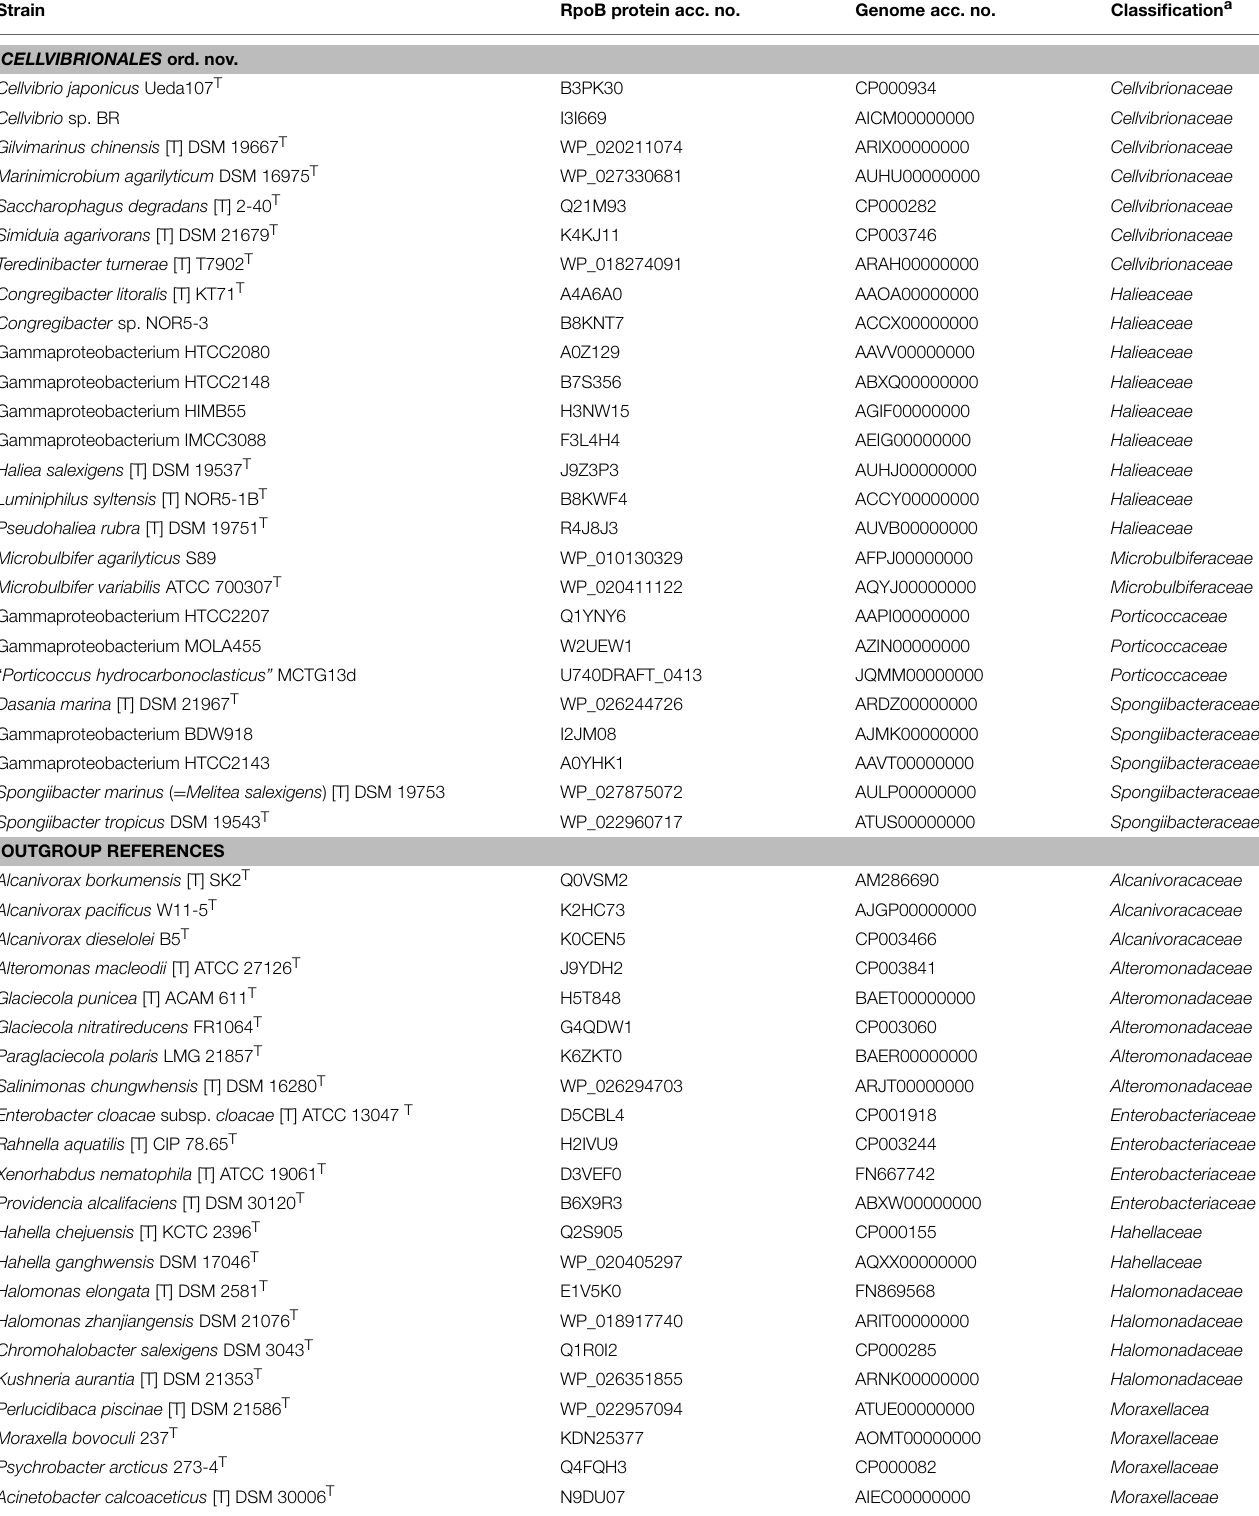
TABLE 1 | Dataset of RpoB protein sequences and genome sequences used for the reconstruction of RpoB-based trees or supermatrix trees based on whole proteomes. Strain RpoB protein acc. no. Genome acc. no. CELLVIBRIONALES ord.